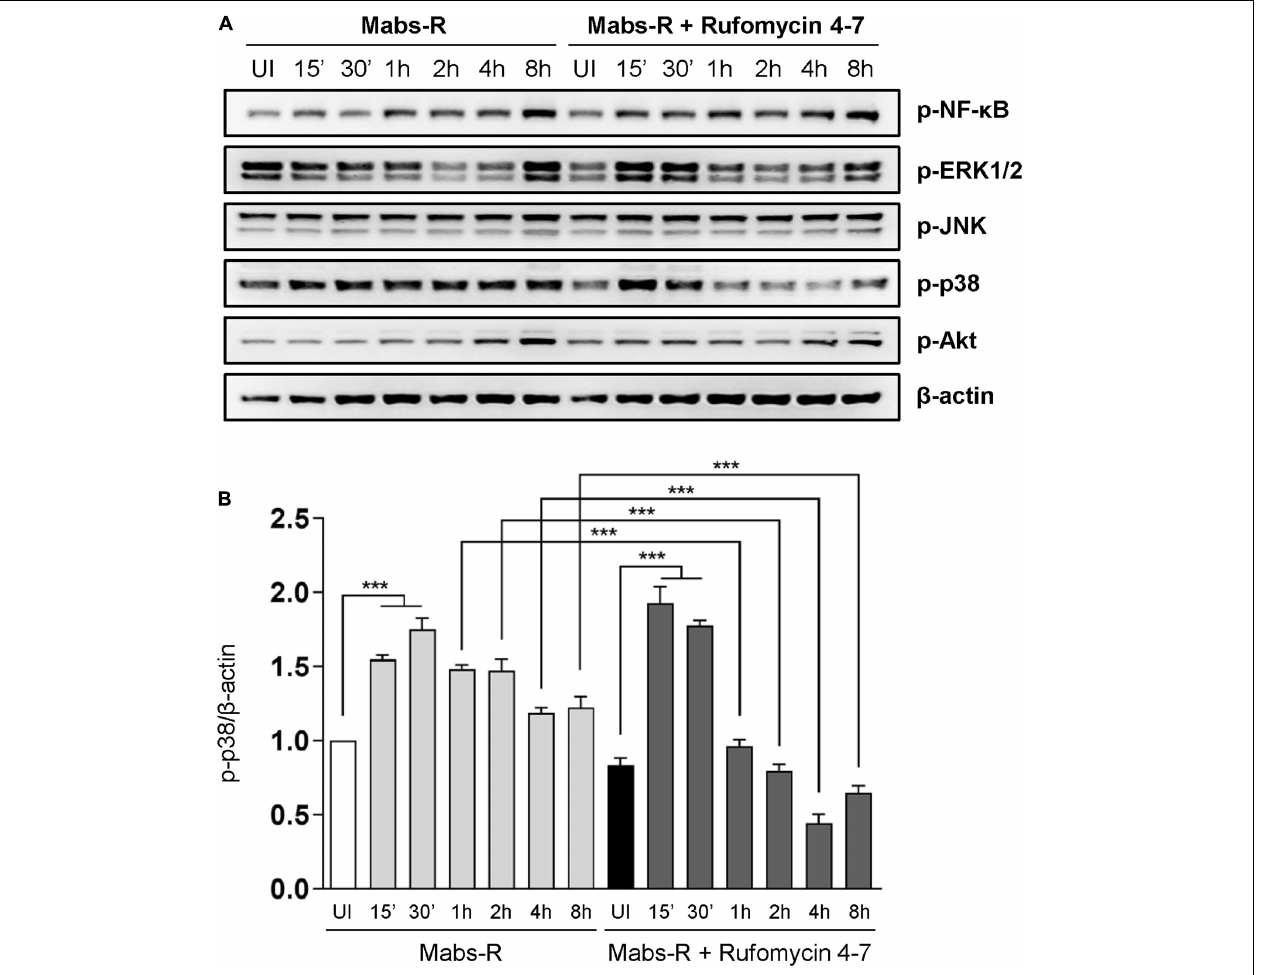
FIGURE 3 | Rufomycin 4–7 decreases Mabs-R-induced p38-MAPK inflammatory signaling in macrophages. (A) BMDMs were pretreated with Rufomycin 4–7 (10 µ M) or vehicle and infected with Mabs-R (MOI = 3) for the indicated times. Cells were lysed and subjected to immunoblot analysis with antibodies of p-NF- κ B, p-ERK, p-JNK, p-p38, p-Akt, and β -actin. (B) Densitometric analysis was performed and normalized to β -actin with the p-p38 band. *** p < 0.001. Statistical analysis was determined with one-way ANOVA and presented as means ± SD (B) . Western blot images are representative of three independent experiments (A) . UI,